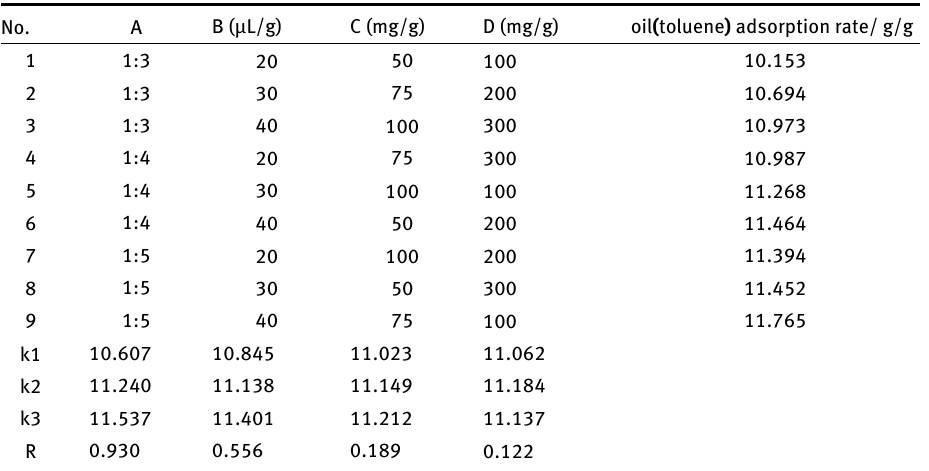
Table 2: Results of orthogonal experiment